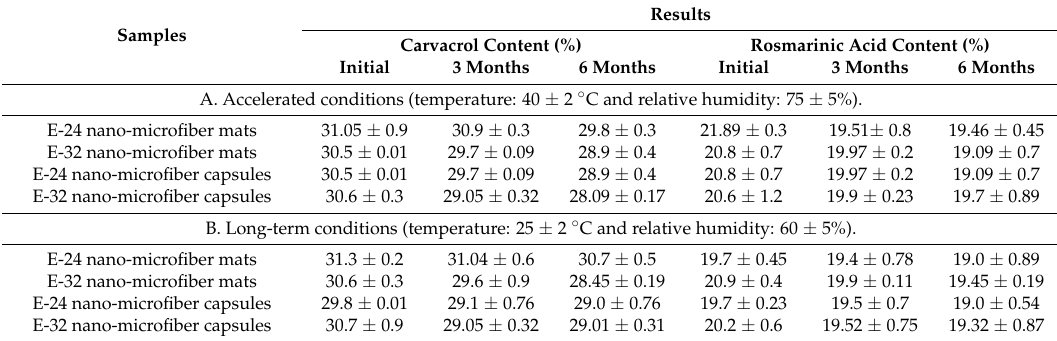
Table 4. Electrospun nano-microfibers mats and capsules properties during 6 months storage under accelerated and long-term conditions ( n =